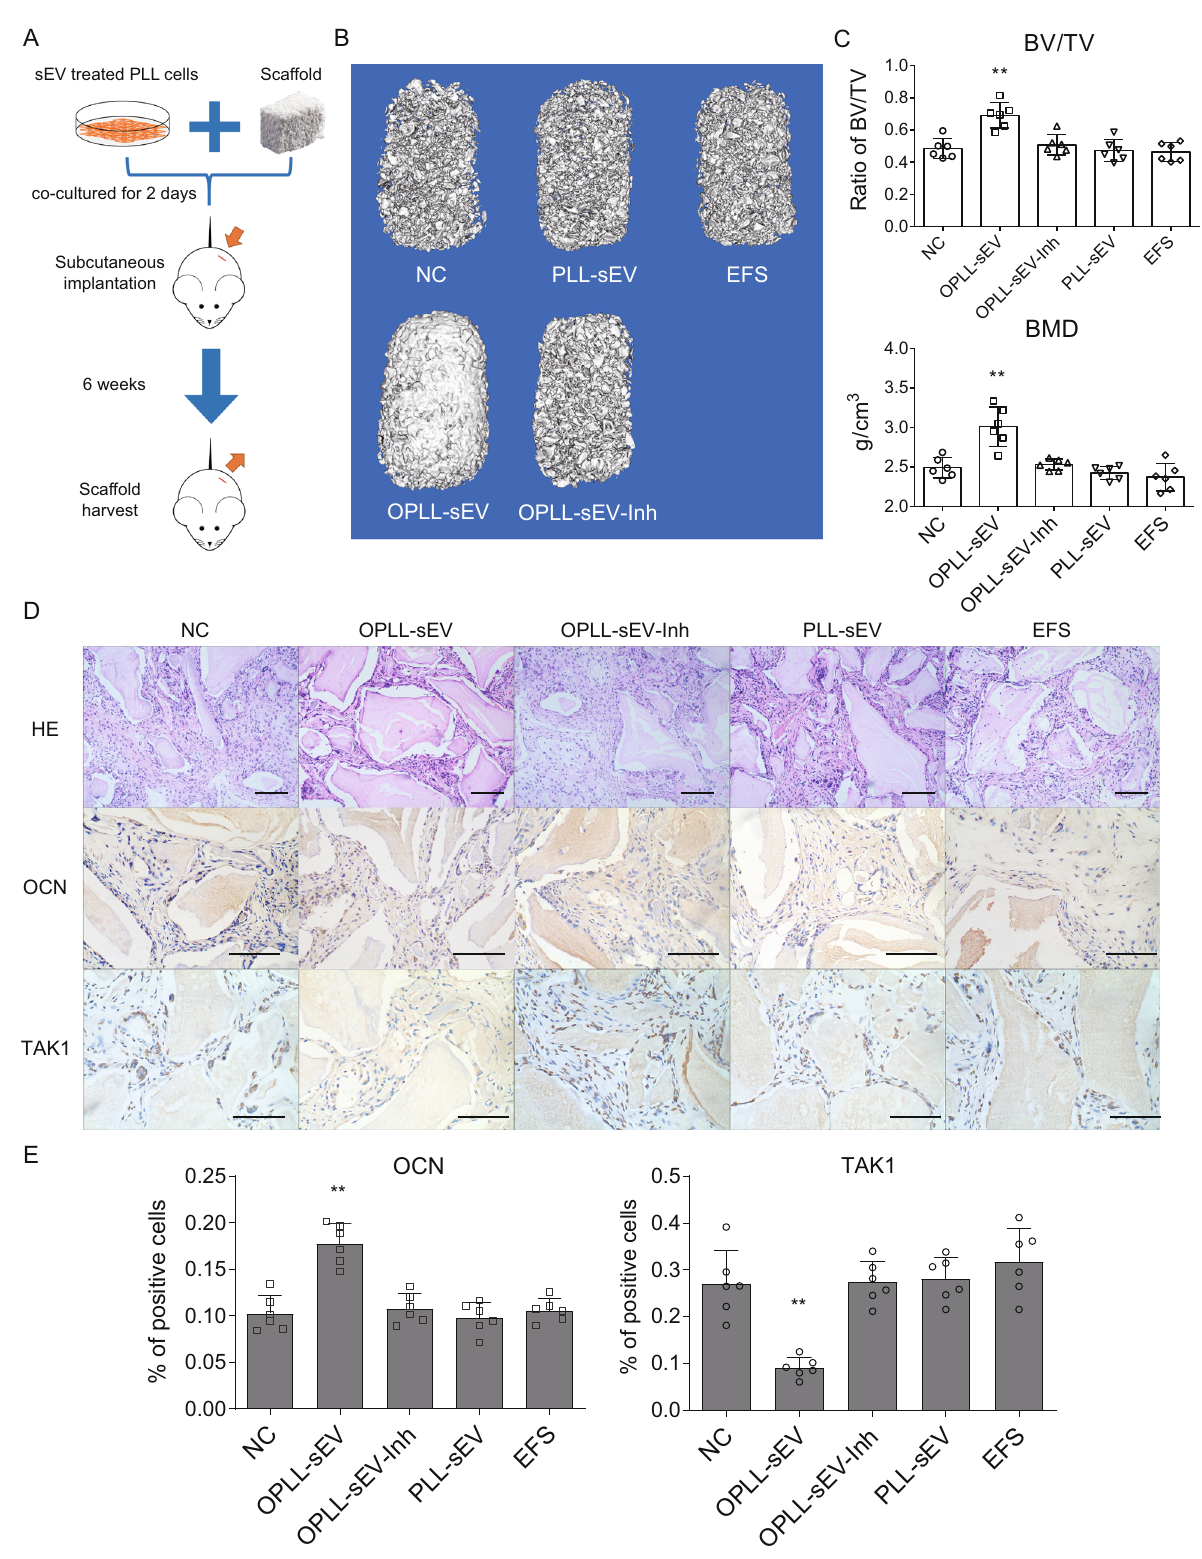
Fig. 9 miR-320e promoted heterotopic bone formation in vivo. A Scheme for heterotopic bone formation assay procedure. Small EVs (sEV) were treated with OPLL cells prior to implantation. B Representative reconstructed three-dimensional micro-CT images of implanted bio-scaffold after 6 weeks, n = 6 for each group. C Bone analysis showing the BV (bone volume)/TV (tissue volume) and BMD (bone marrow density) of cultured bone constructs ( n = 6, one-way ANOVA). D H&E staining and immunohistochemical staining of implanted bio-scaffold after 6 weeks in respective groups, n = 6 for each group. The scale bars represent 500 μ m. E Quanti fi cation of OCN and TAK1 expression in the immunohistochemical staining of implanted bio-scaffold after 6 weeks ( n = 6, one-way ANOVA). All data were presented as the mean±SD. * p <0.05, ** p <0.01. Detailed statistical data and source data are provided in a Source Data fi